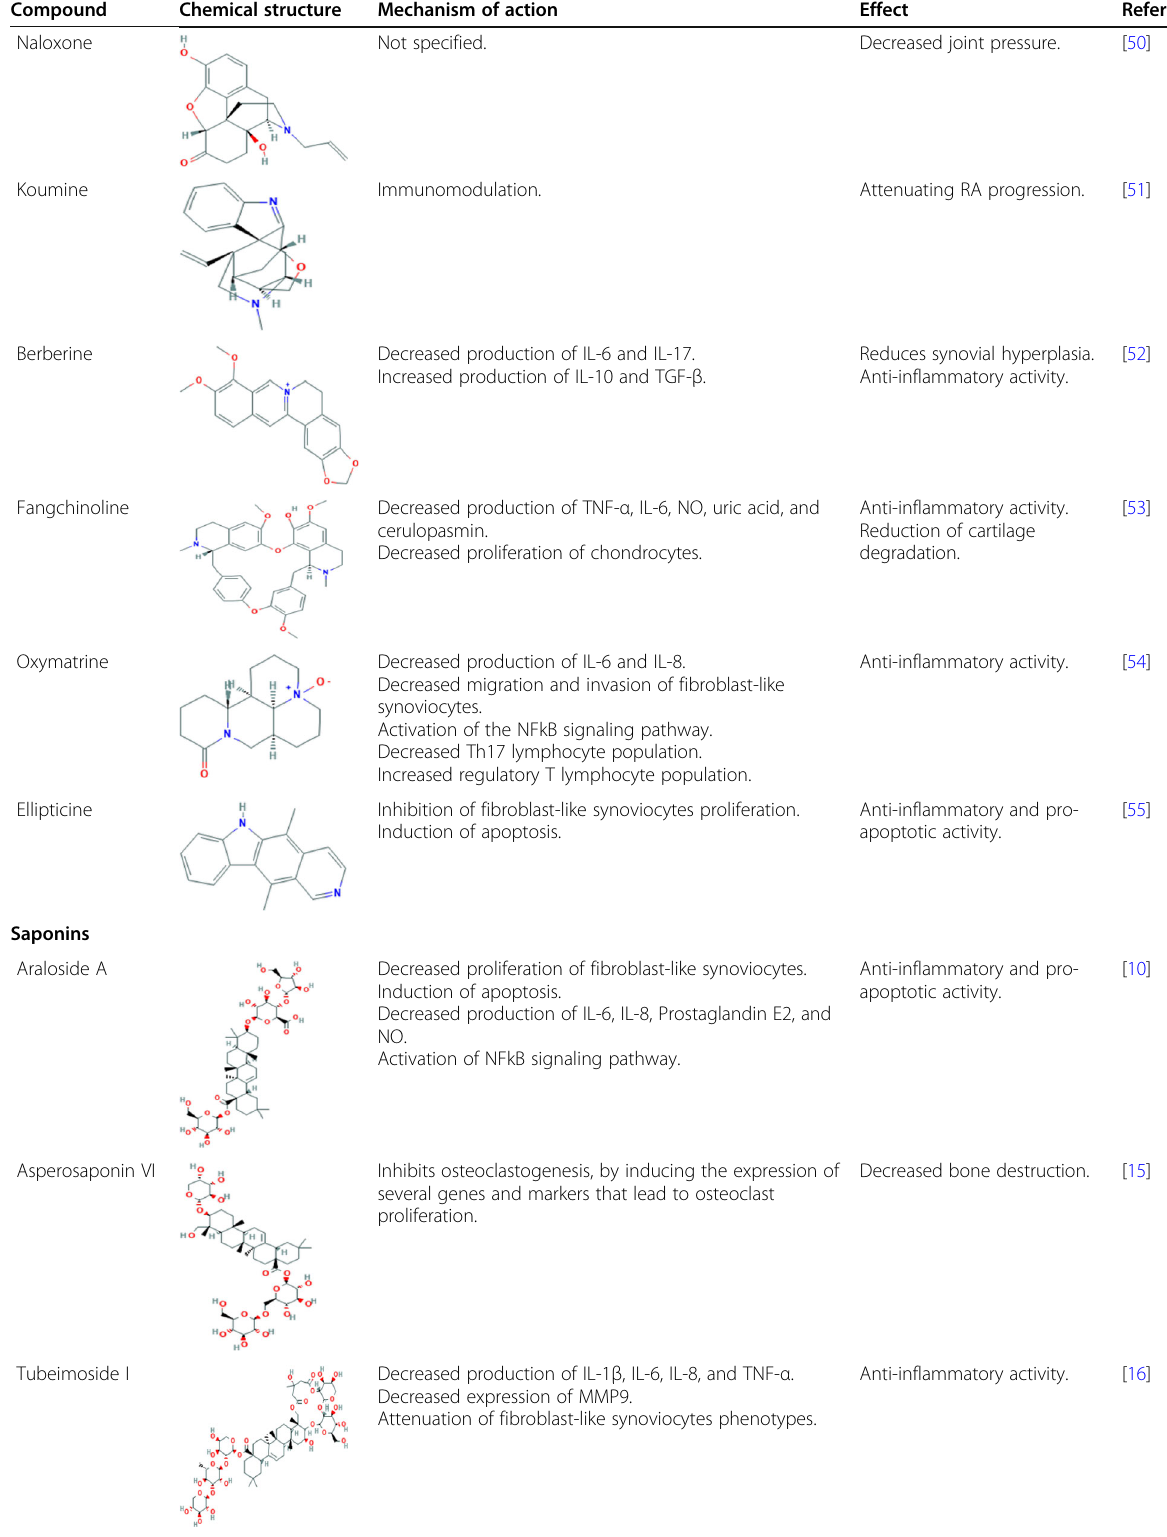
Table 2 Phytochemicals used in the treatment of rheumatoid arthritis